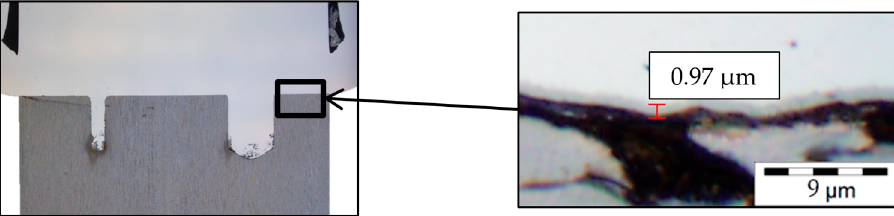
Figure 12. ( Left ) overview of Geometry C, and ( right ) dark layer on the aluminum side close to the joining zone.